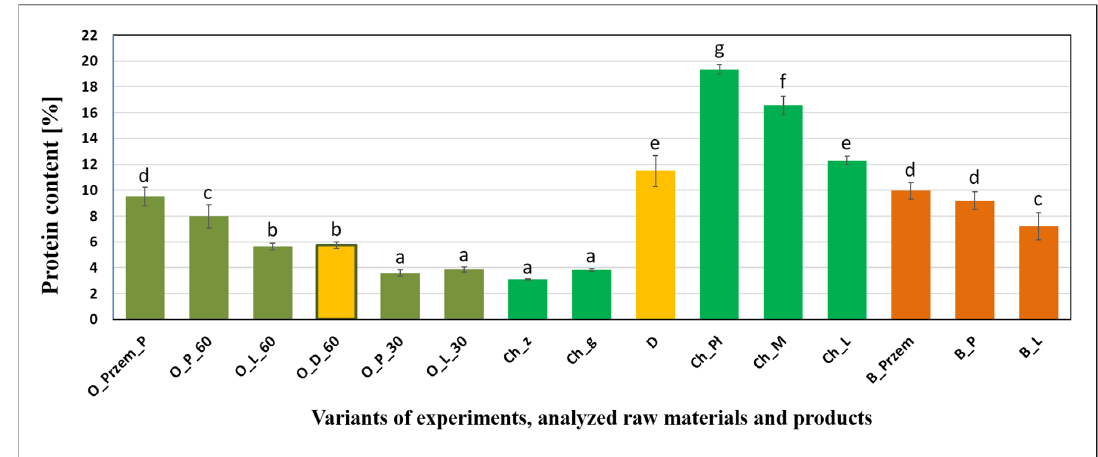
Figure 2. Protein content in beer wort, hot trub, yeast, and raw materials (n = 5, α = 0.05; homogeneous groups of results within a given parameter are marked with letters).